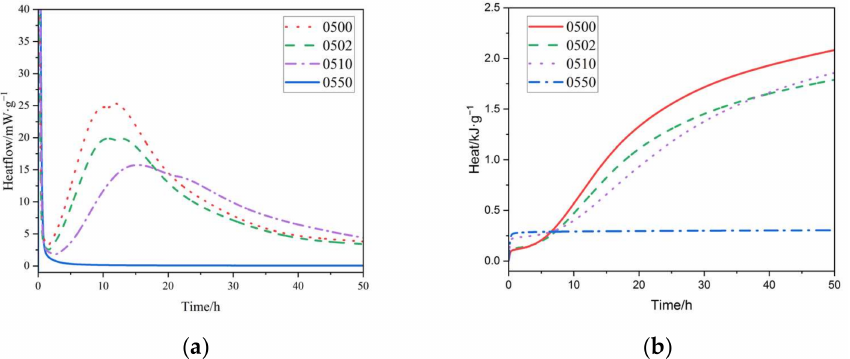
Figure 8. ( a ) Rate of hydration heat release of cement paste (W/C = 0.5) with different content of PEG-600. ( b ) Hydration heat curves of cement paste (W/C = 0.5) with different content of PEG-600.